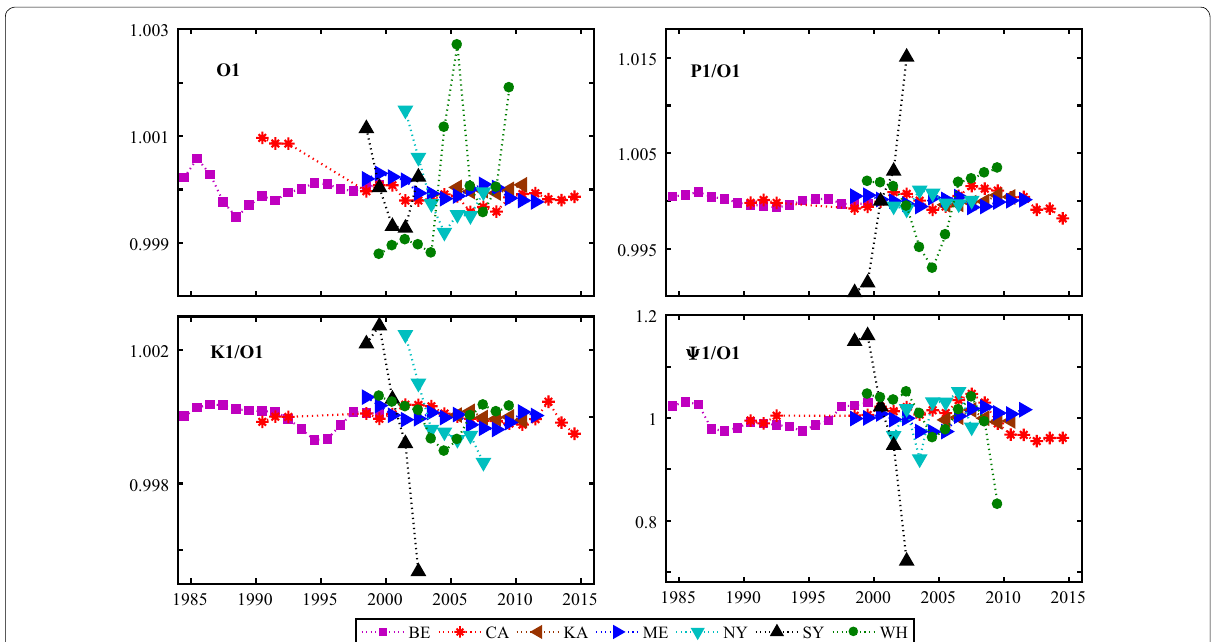
Fig. 9 Amplitude factor of diurnal waves in the third station class. Amplitude factors of P1, K1 and ψ1 waves are normalized by the one of the O1 waves. All amplitude factors are then divided by their mean value for the convenience of